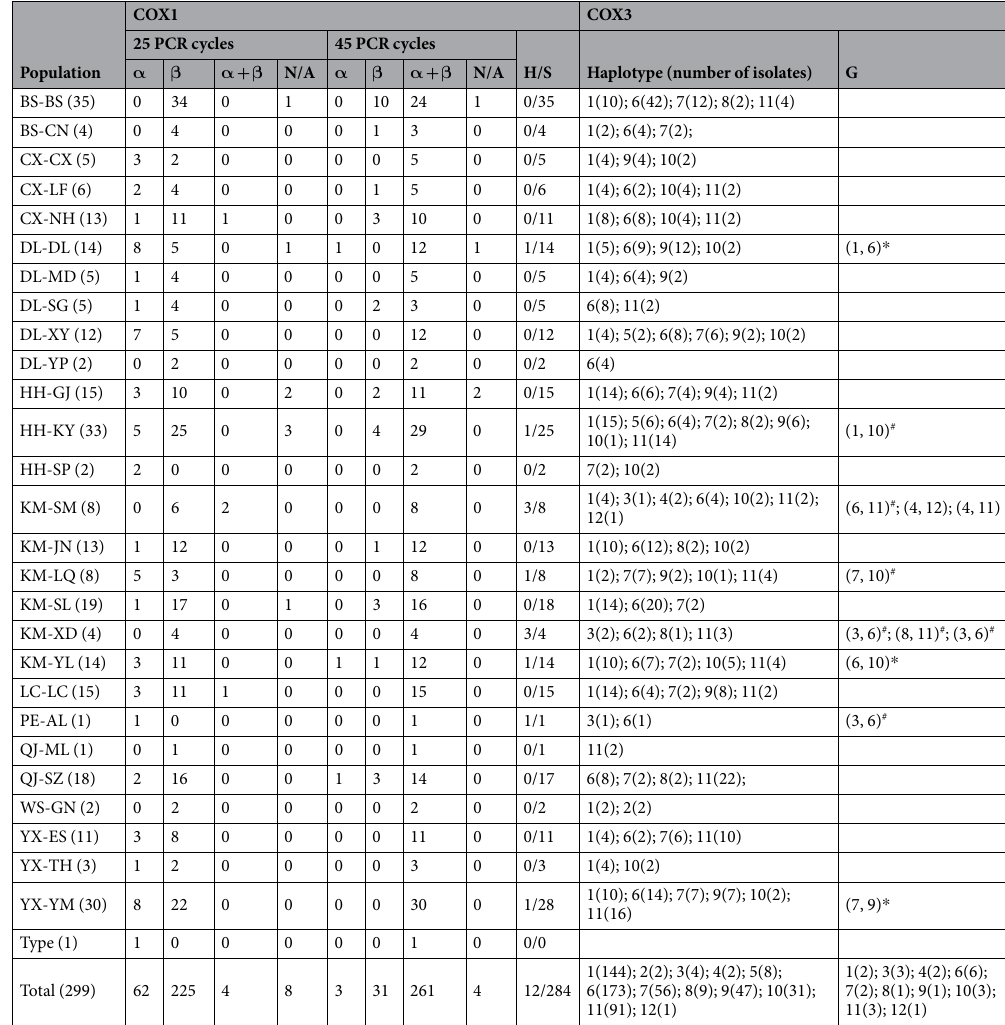
Table 3. Geographic distribution of the α and β COX1 gene fragments, and the haplotype composition analysis of COX3 gene fragment among samples of Th. ganbajun in southwest China. Population abbreviations refer to Table 1. The numbers after the abbreviations indicate the population sizes. Genotyping primer pairs were used to screen all 299 clade I samples using 25 cycles (for the more abundant copy) as well as 45 cycles (for the less abundant copy) of PCR reactions. The α , β and α + β notations indicate that only COX1- α , only COX1- β and both the COX1- α + COX1- β exist respectively. N/A: not available, indicating those that failed to amplify. H/S: the number of COX3 heterozygous isolates in each geographic sample and in the total sample. Haplotype: COX3 haplotypes after PHASE. G: COX3 genotype of heterozygous isolates. Genotypes with “ * ” and “ # ” indicate these heteroplasmy can be interpreted by the mixture of two haplotypes from other homozygous isolates within the local population and among whole population,